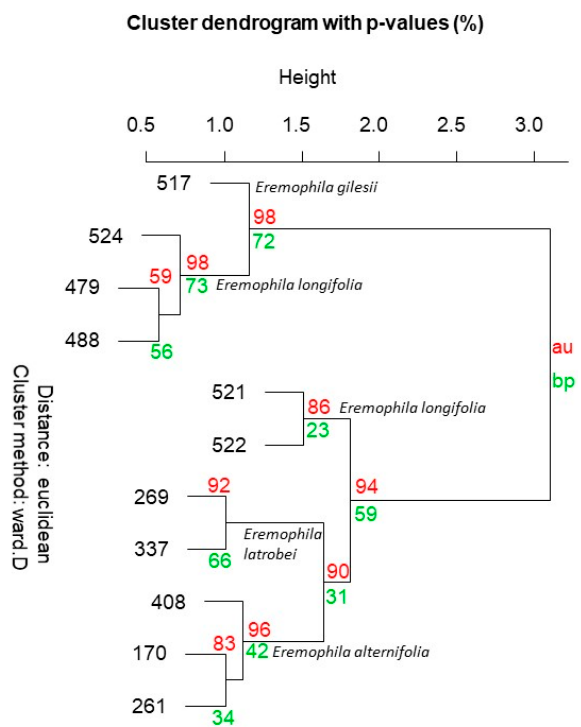
Figure 4. Dendrogram of essential oil components from Eremophila longifolia , E. alternifolia and E. latrobei .